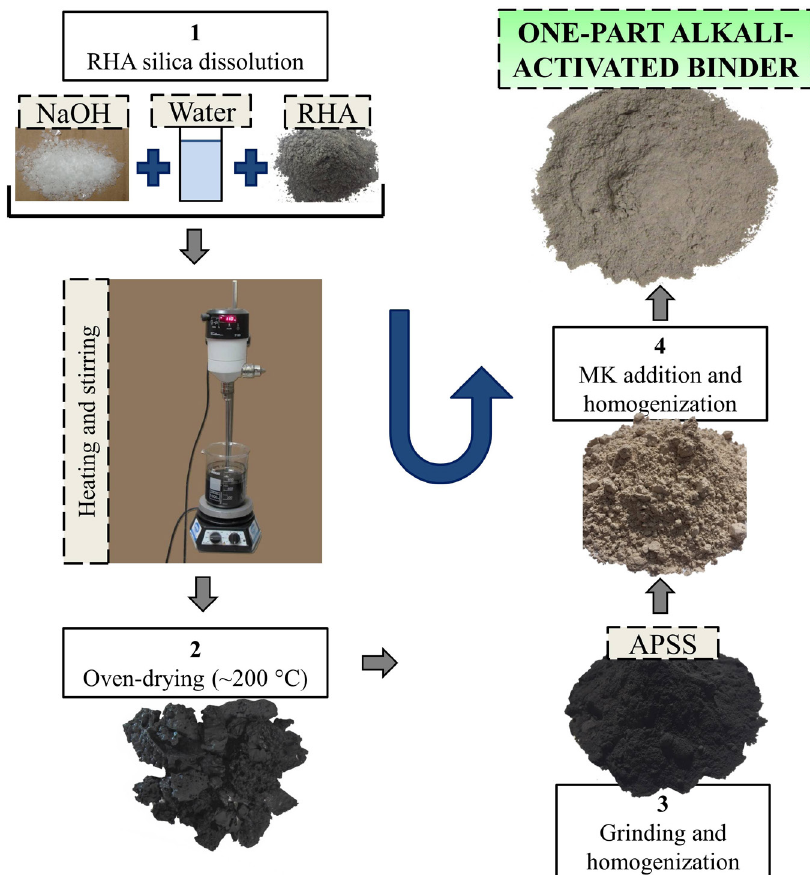
Figure 4. Steps to production of one-part AAB